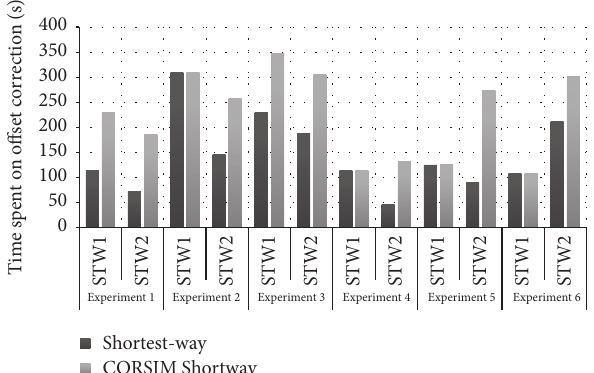
Figure 6: Time spent on offset correction.